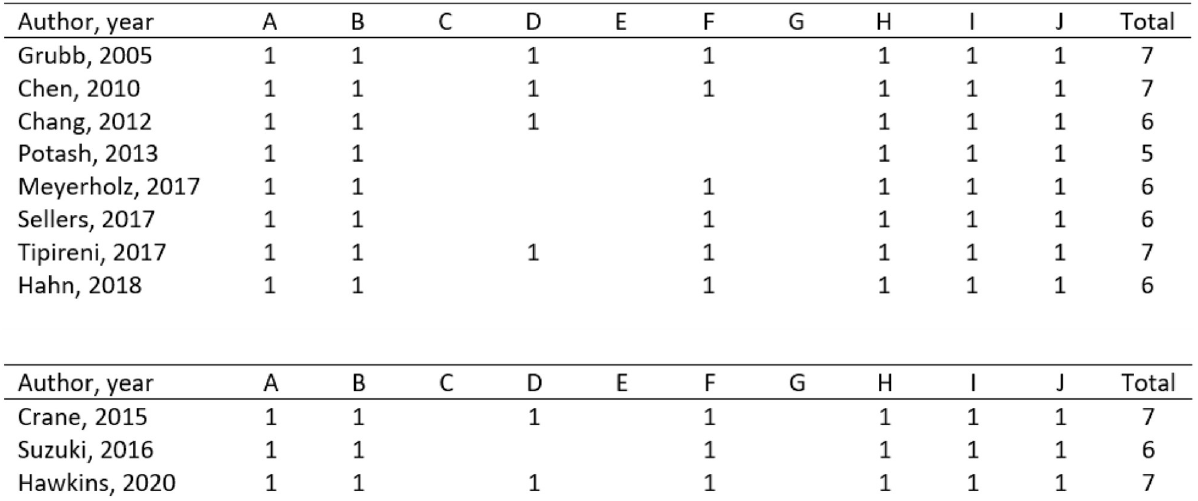
Fig 1. Risk of Bias Assessment of included studies, Top Panel: Animal Models Studies, Bottom Panel: iPSCs Studies. A: Sequence generation, B: Baseline characteristics, C: Allocation concealment, D: Random housing, E: Blinding (in terms of reducing performance bias), F: Random outcome assessment, G: Blinding (in terms of reducing detection bias), H: Incomplete outcome data assessment, I: Selective outcome reporting, J: Other sources of bias. References: Sellers [27]; Meyerholz [26]; Hahn [25]; Grubb [31]; Potash [33]; Chang [34]; Chen [35]; Tipirneni [32]; Suzuki [28]; Hawkins [30]; Crane